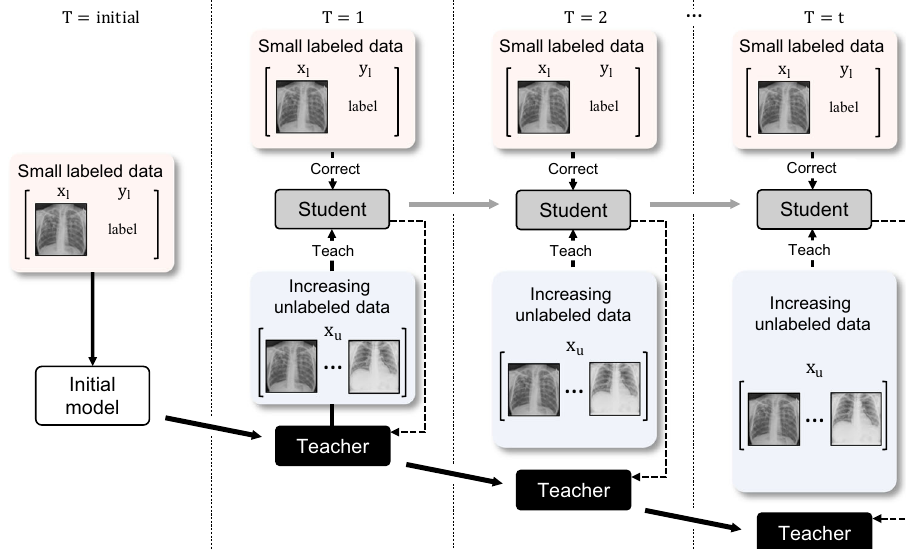
Fig. 2 Simulation of clinical application for increasing data over time. The initial model is trained with small labeled data. Then, using this initial model as teacher and small initial data for correction, the student is trained with the DISTL method under an increasing amount of data over time T